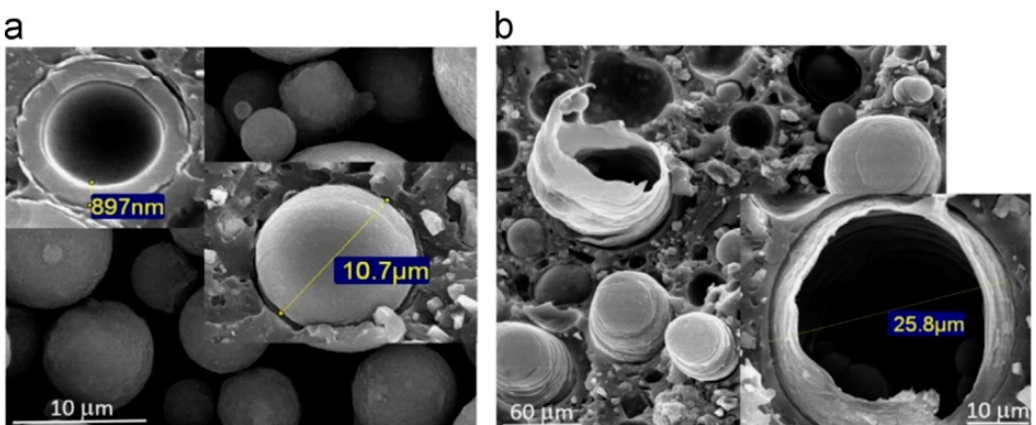
Figure 12. SEM image of TEPs before ( a ) and after expansion ( b ). [206] Reprinted from International Journal of Adhesion and Adhesives, Vol 54, Banea et al., “Mechanical and thermal characterization of a structural polyurethane adhesive modified with thermally expandable particles”, Pages No 191–199, Copyright (2014), with permission from Elsevier.